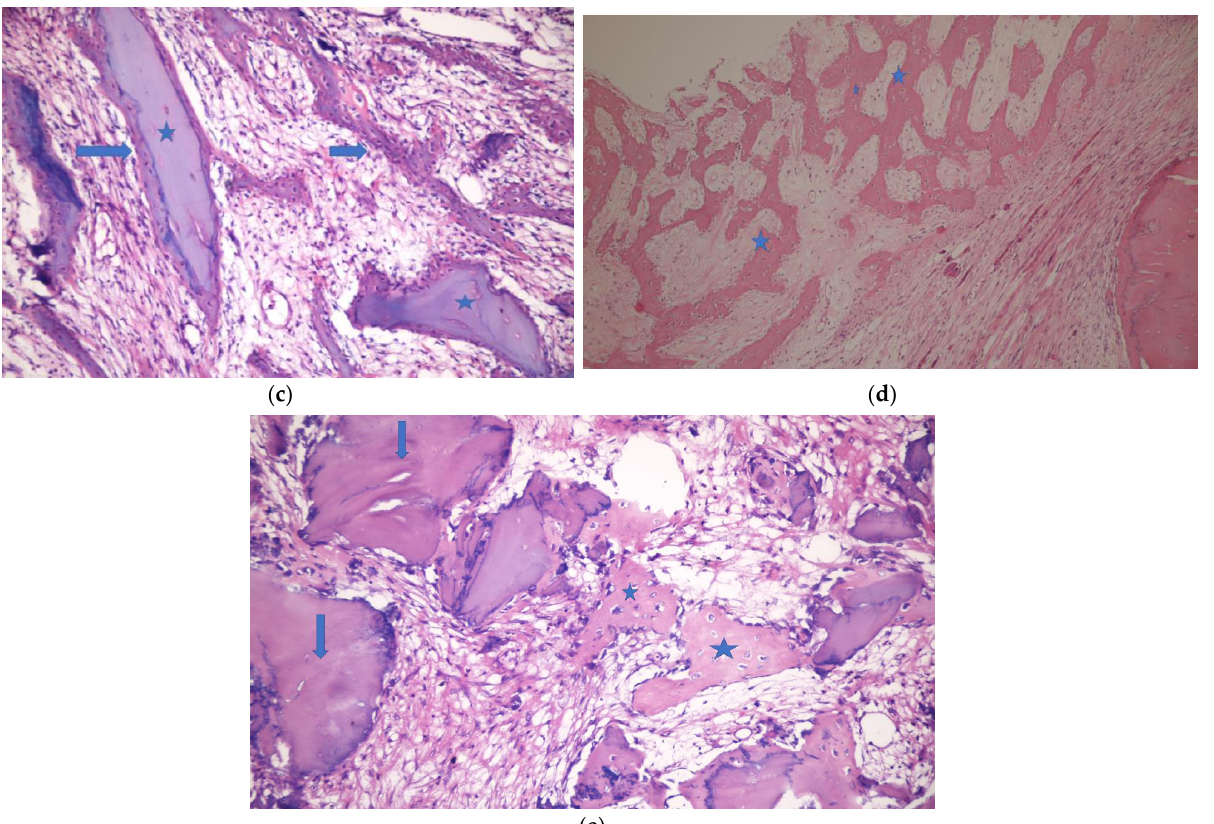
Figure 5. Week 3. ( a ). Empty defect group. Dense vein proliferation in the defect area and fibrosis are observed. Active osteoblasts around the bone stand out in the new bone formation areas. *: new bone formation areas; arrows: fibrosis (H&E × 200). ( b ). HY defect group. New bone formation in the defect area and hyalinized collagen tissue at the periphery are